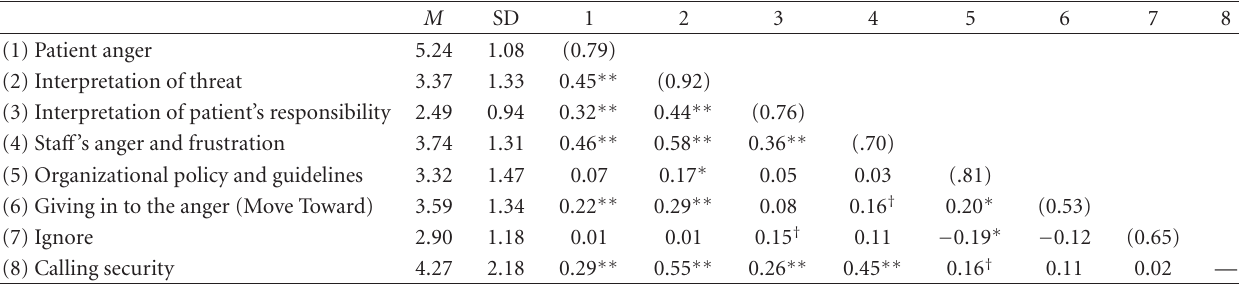
Table 1: Correlations between all the study variables. For example row 1 shows all the correlations with “Patient anger intensity” so the correlation between this variable and ignoring is 0.01.